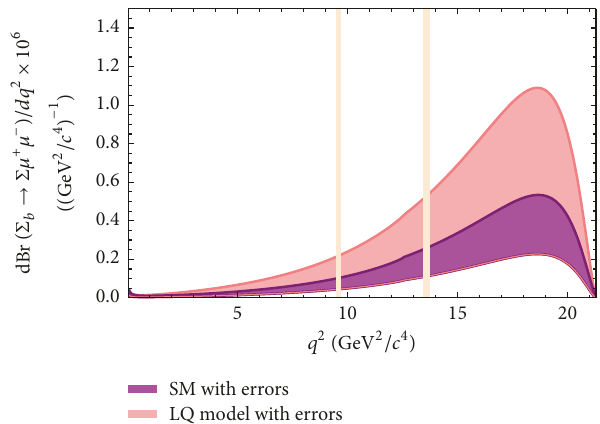
Figure 2: The dependence of the differential branching ratio on 𝑞 2 for the Λ 𝑏 → Λ𝜏 + 𝜏 − transition in the SM and LQ models. The vertical shaded band indicates the charmonia veto region.